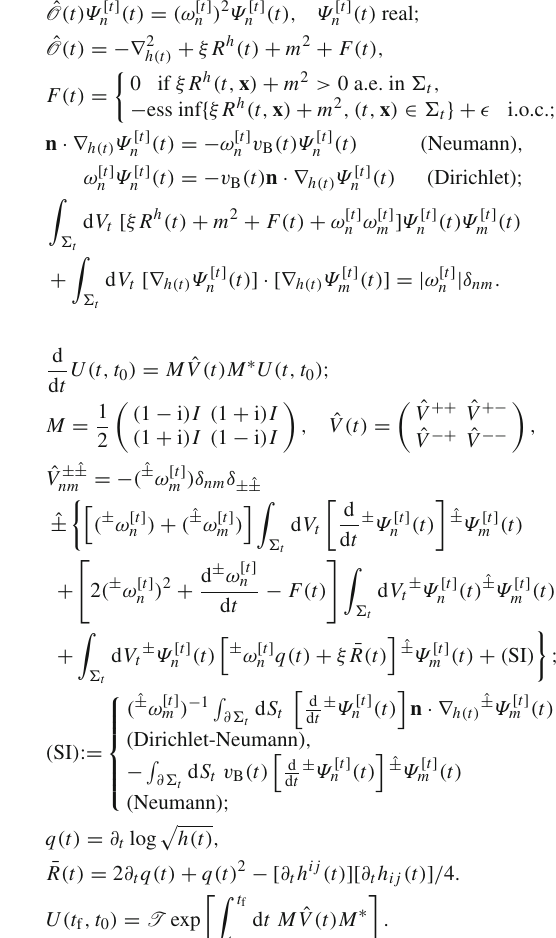
Table 1 Summary of formulae for the application of the method (part 1) Computation of the auxiliary modes and eigenvalues (Pseudo-)eigenvalue equation